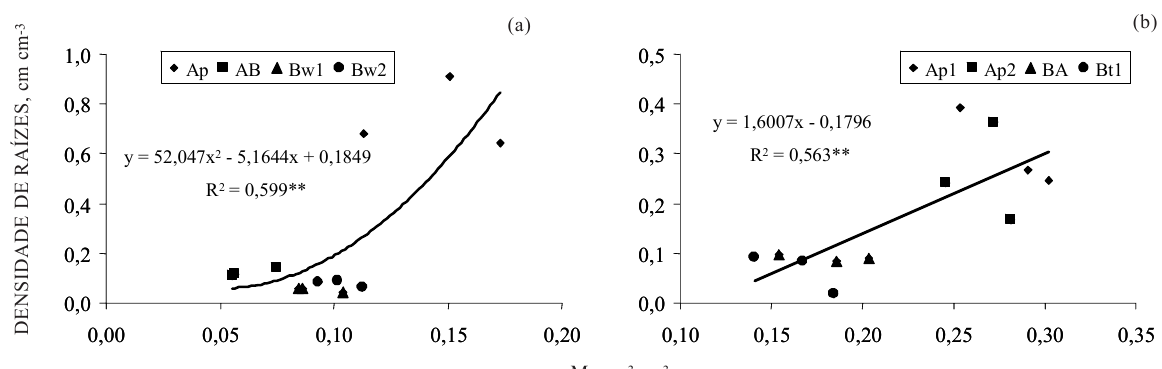
Figura 5. Relação entre densidade de raízes de citros e macroporosidade (Mp), em Latossolo Amarelo (a) e Argissolo Acinzentado (b) de Tabuleiros Costeiros da Bahia, na avaliação de indicadores de horizontes